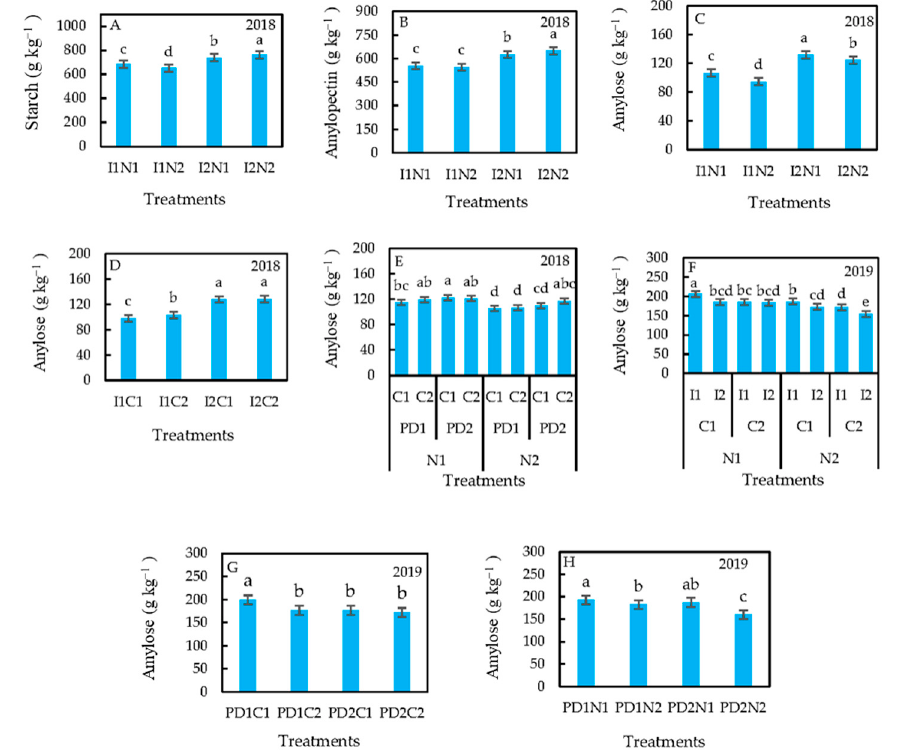
Figure 4. Least square means of maize grain starch ( A ), amylopectin ( B ) and amylose ( C ) in response to interaction effects of irrigation and nitrogen, and least square means of maize grain amylose in response to interaction effects of irrigation and cultivar ( D ); nitrogen, planting date and cultivar ( E ); nitrogen, cultivar and irrigation ( F ); planting date and cultivar ( G ); and planting date and nitrogen ( H ). I1, irrigation at 12-day intervals; I2, irrigation at 6 day-intervals; PD1, planting date 21 June; PD2, planting date 22 July; C1, KSC704; C2, KSC260; N1, 0; N2, 184 kg N ha − 1 . Least square means labelled with the same letter do not differ significantly at p < 0.05 based on Tukey’s test. Vertical bars represent the 95% confidence interval.